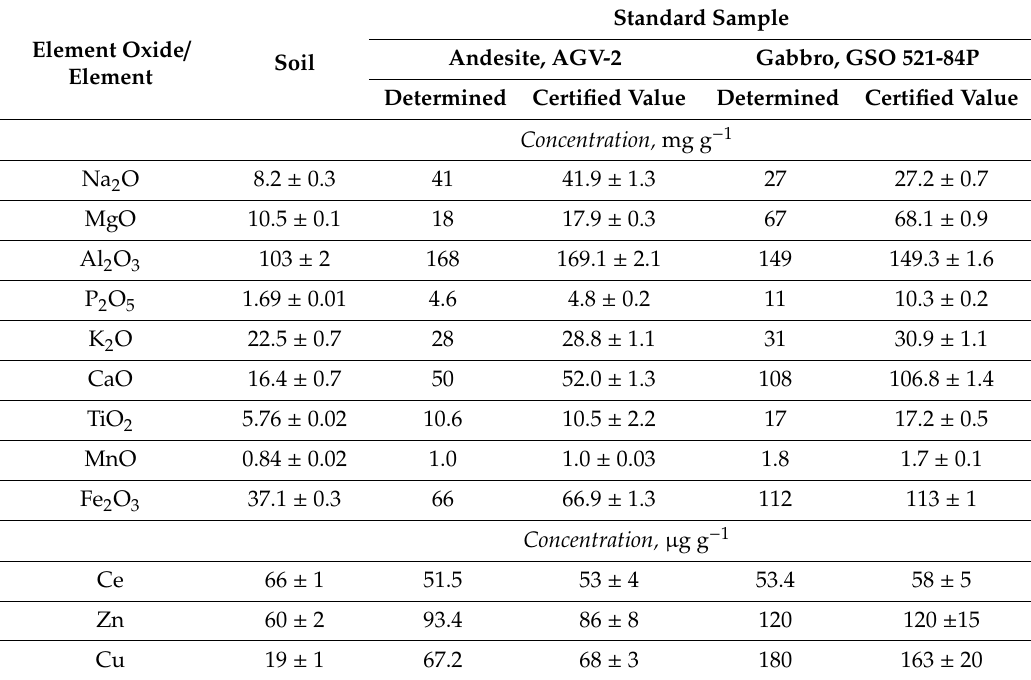
Table 1. Chemical composition of soil sample ( mean ± standard deviation